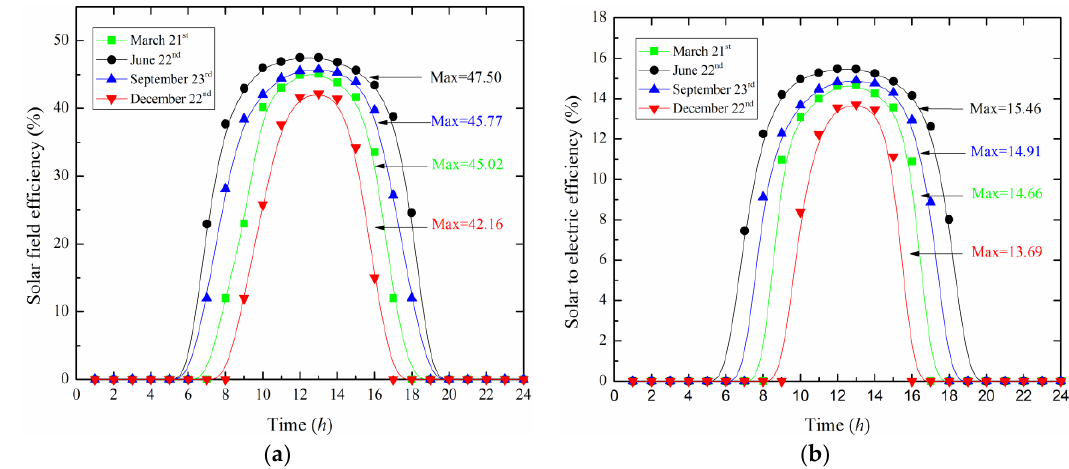
Figure 2. The performance of solar field variation with time. ( a ) The solar field efficiency variation with time. ( b ) The solar-to-electric efficiency variation with time.